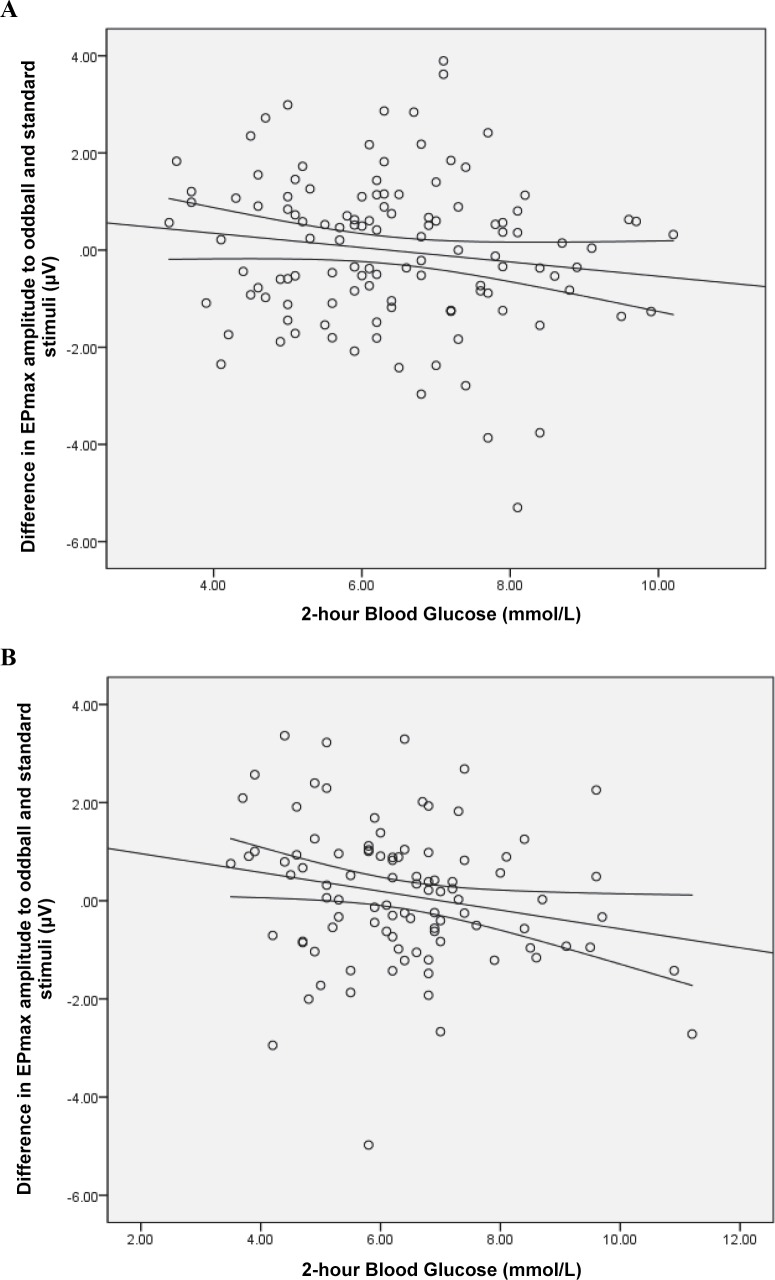
Scatterplots of stimuli difference (oddball-standard) in EPmax amplitudes, over the left hemisphere.Stimuli difference in EPmax amplitudes over the left hemisphere in A) 6 months and B) 18 months old infants against maternal 2-hour plasma glucose at 26–28 weeks gestation. Curves lines correspond to 95% confidence interval of the mean.